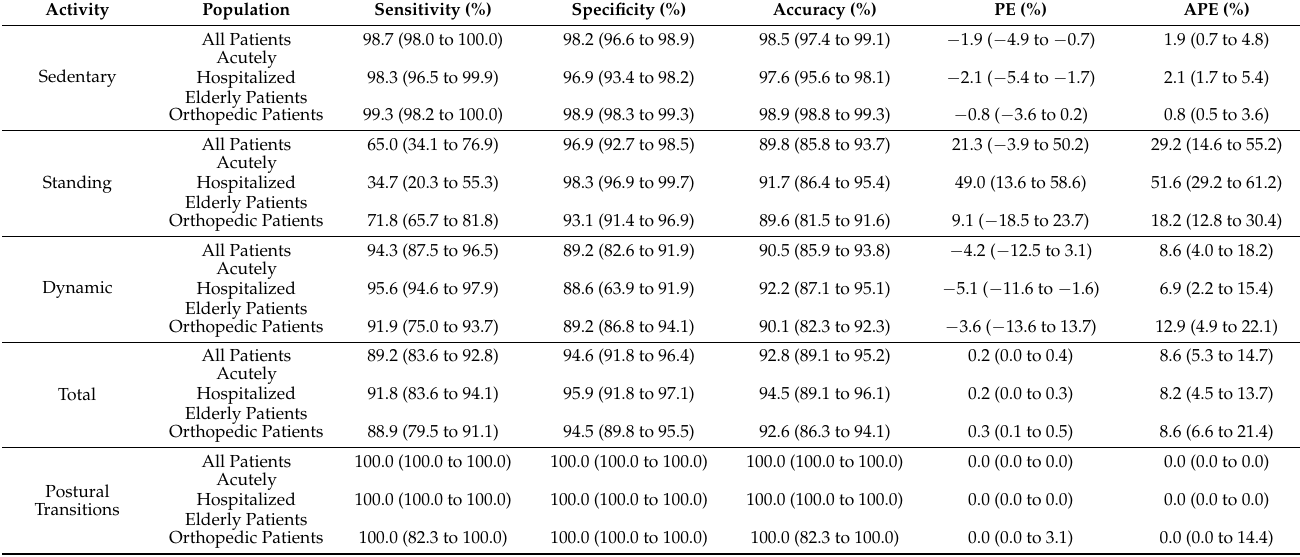
PE = percentage error. APE = absolute percentage error. MOXAL = adjustable classification algorithm validated in community-dwelling healthy elderly persons with an upper leg wear location, used as the starting point for the optimization process. MOXAL Opt = classification algorithm after optimization of three adjustable parameter settings of MOXAL to reduce the absolute percentage error for total activity. HFITAL = classification algorithm after additional modifications were introduced to MOXAL regarding the decision tree and the calculation of the amount of physical